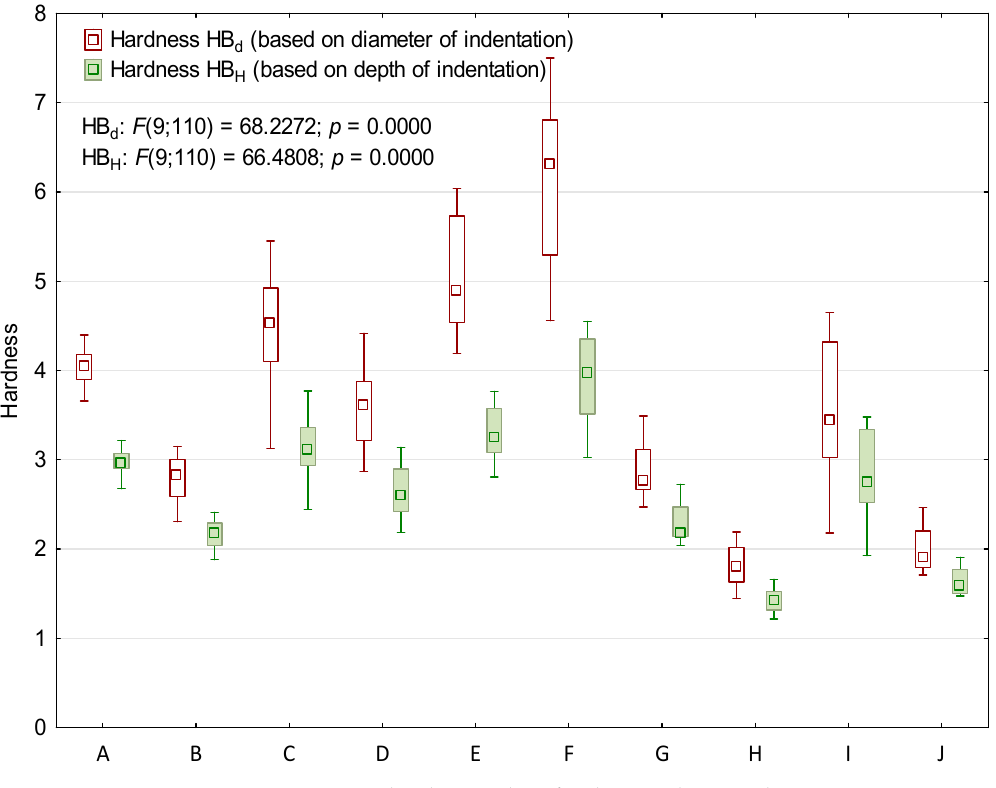
Figure 5. Average hardness values for the tested materials.